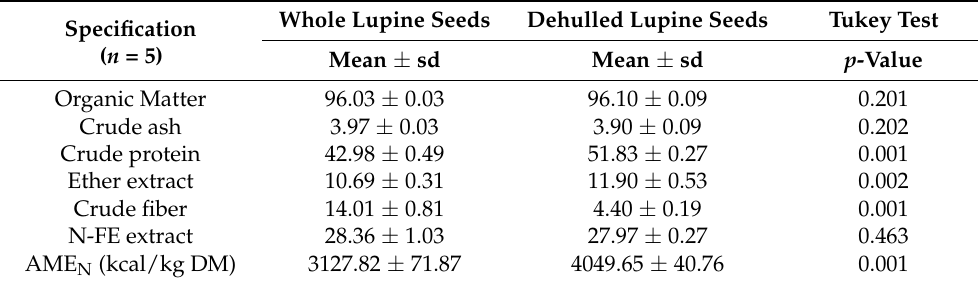
Table 2. Dehulling influence on the raw chemical composition of L. albus seeds (cv. Amiga), from low-alkaloid varieties (% of Dry Matter).